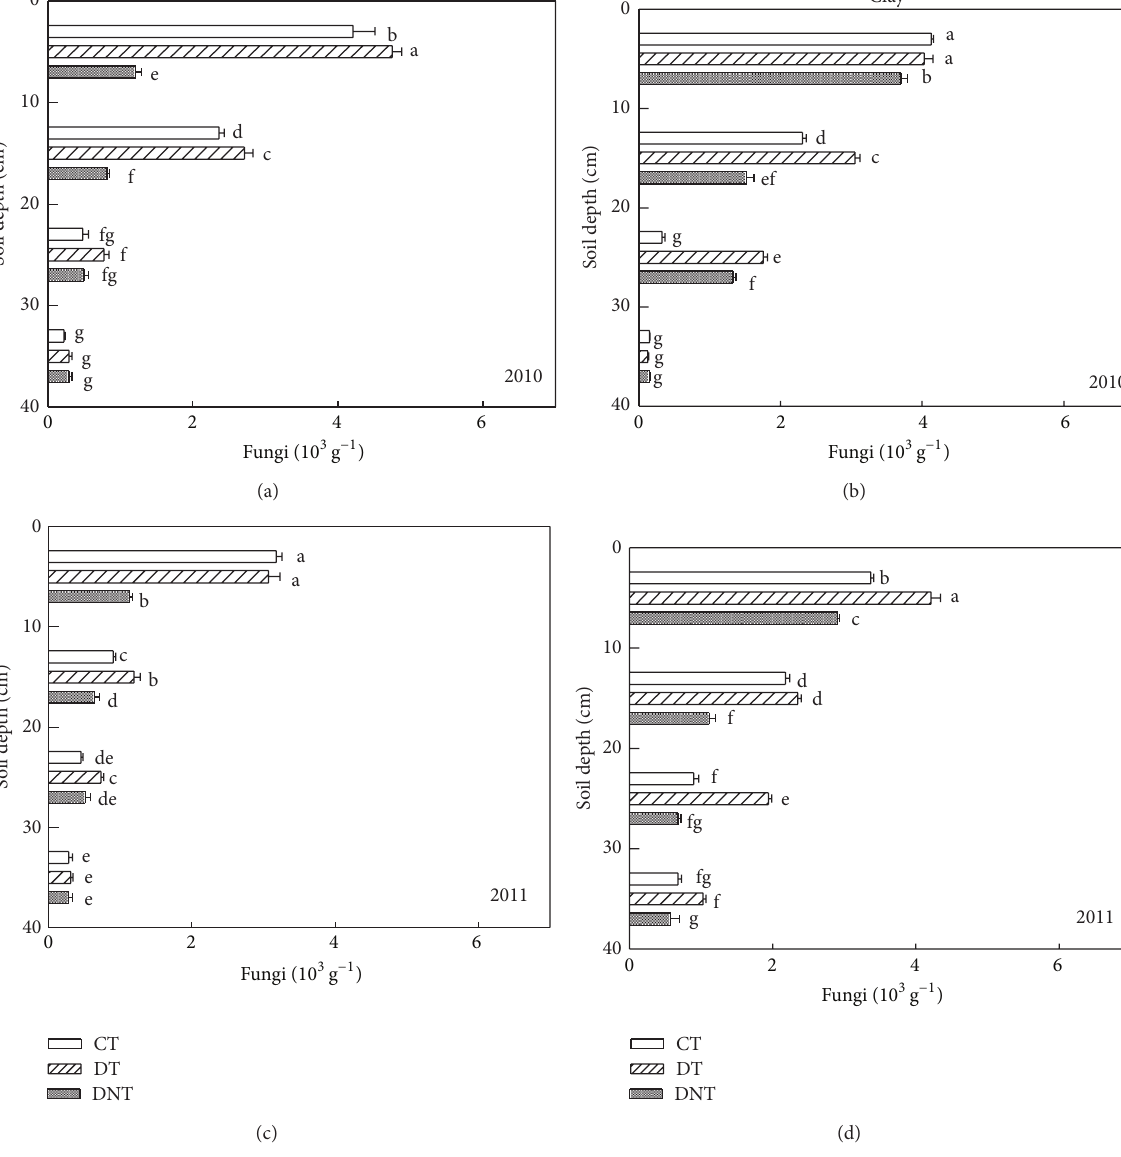
Figure 3: Effects of tillage and straw returning on the number of soil fungi. Different small letters indicated significant difference at 𝑃 < 0.05 according to Duncan’s test. CT represented conventional tillage, moldboard ploughed to a depth of 20 cm, and straw was returned. DT represented deep tillage moldboard ploughed to a depth of 30 cm and straw was returned. DNT represented deep tillage moldboard ploughed to a depth of 30 cm and straw was